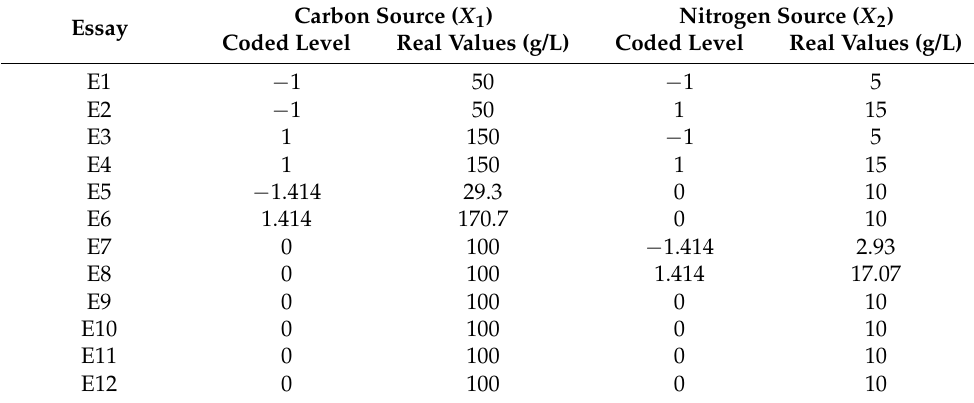
Table 1. CCRD 2 2 planning matrix with growing conditions in coded and real levels of carbon source ( X 1 ) and nitrogen source ( X 2